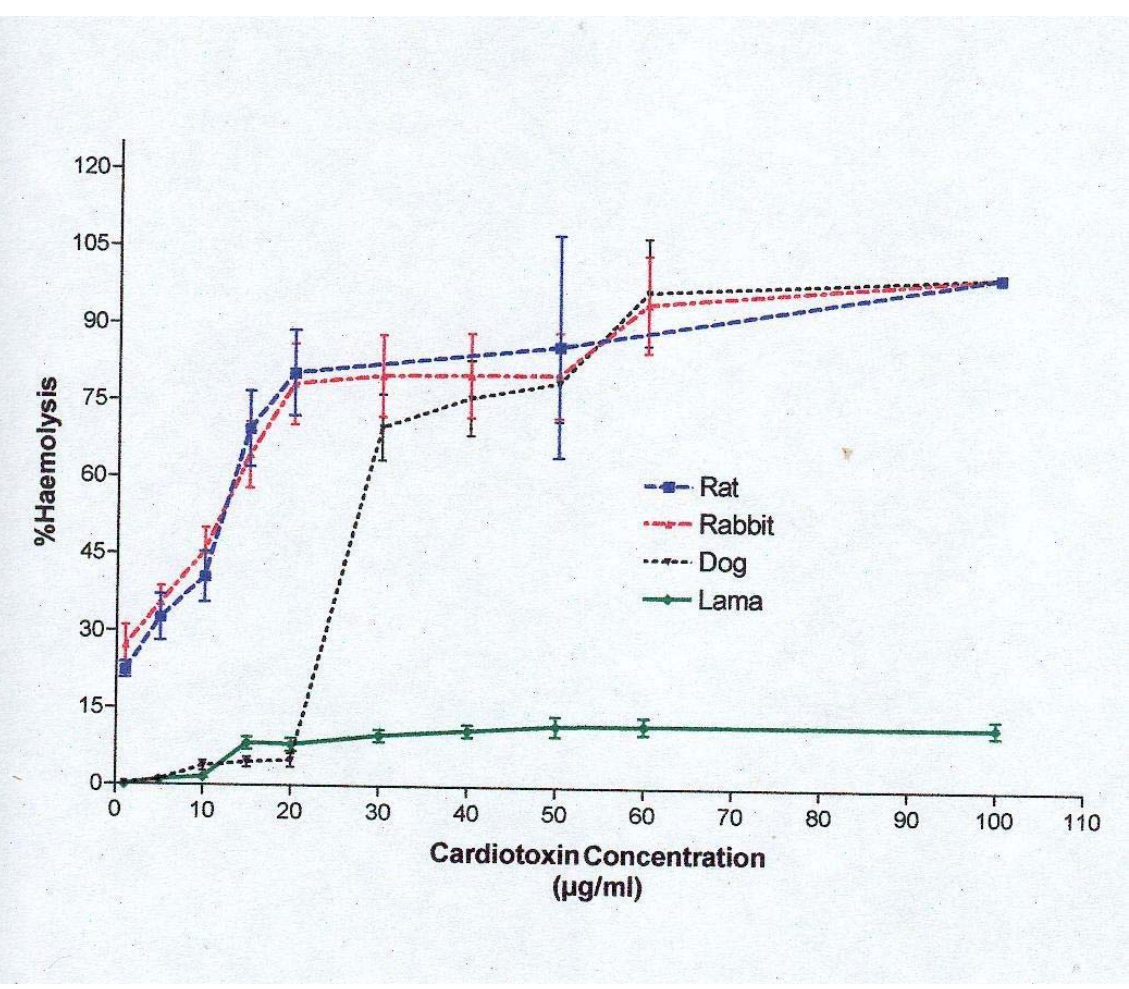
Figure 2. Action of cardiotoxin on red blood cells of rat, rabbit, dog, and lama. Note the characteristic behavior of dog and lama